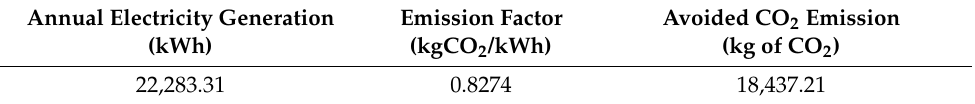
Table 11. Emission of CO 2 avoided due to electricity generation from HPGP.